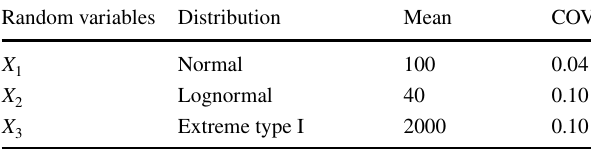
Table 6 Estimated failure probability, relative error and the number of performance function evaluations of different methods on reliabil- ity analysis example